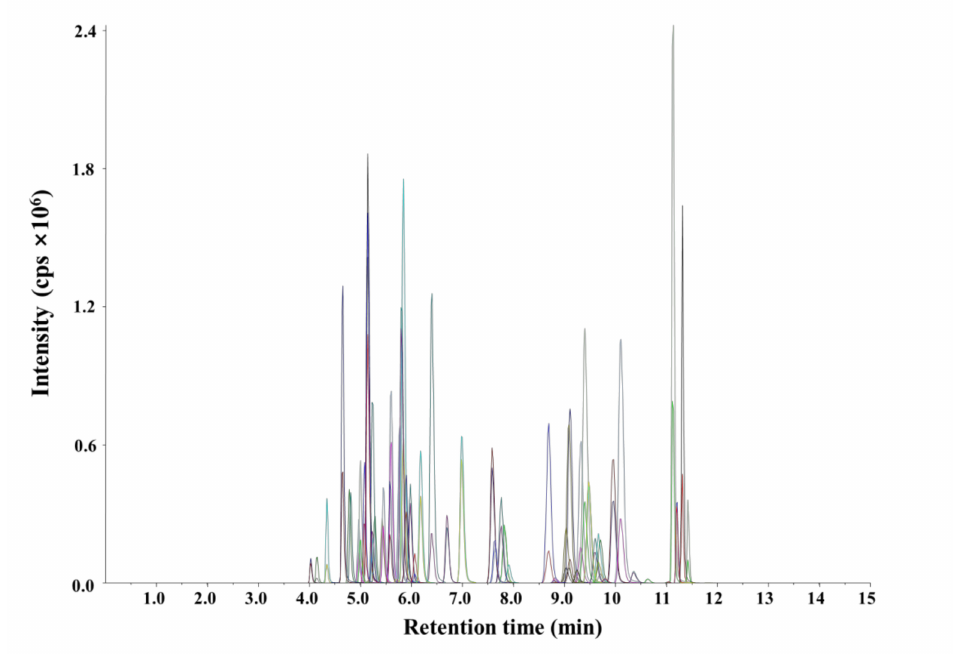
Figure 1. Multiple reaction monitoring chromatogram of 55 pesticides under the optimized LC–MS / MS